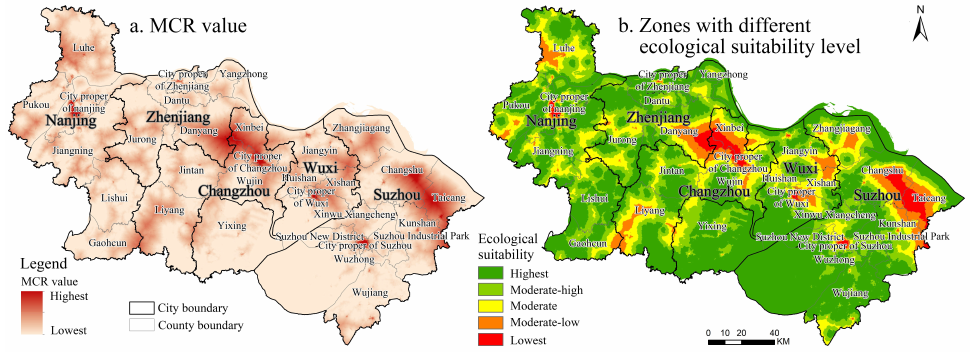
Figure 3. MCR values and zones with different ecological suitability levels in southern Jiangsu.